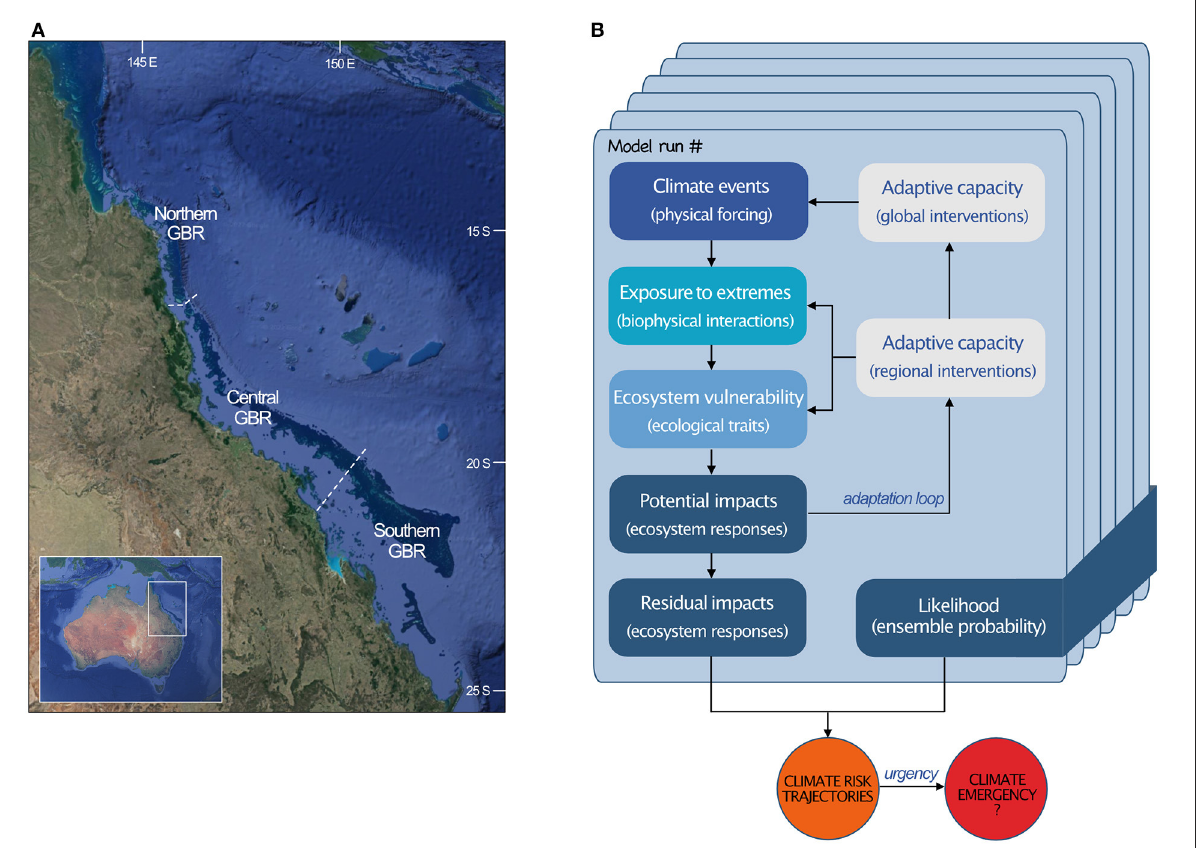
FIGURE1 (A) Map of the Great Barrier Reef (GBR) indicating major zonal regions. (B) Components of the climate risk assessment utilizing ensemble modeling. Adaptive capacity can be in the form of either regional interventions (deployments on the GBR) or global interventions (emission reductions to modify the RCP), both of which were varied to generate the series of climate risk trajectories. The time required to transition from an unacceptable trajectory to an acceptable trajectory is influenced by technological and socio-economic factors. Where that transition cannot be completed before the risk level become unacceptable, a climate emergency is said to